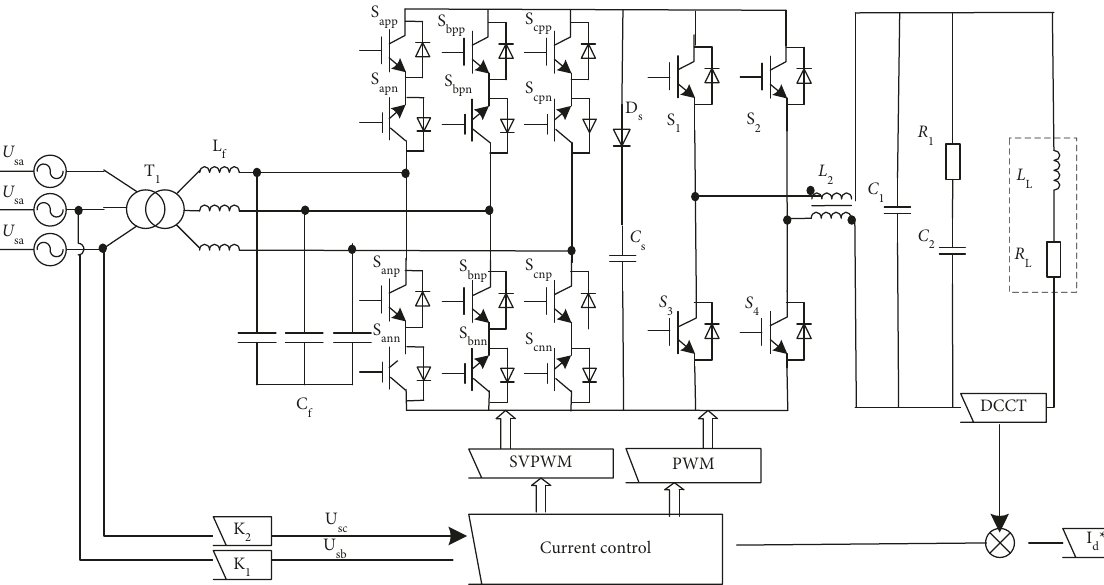
Figure 4: Preceding regulated matrix converter topology and control